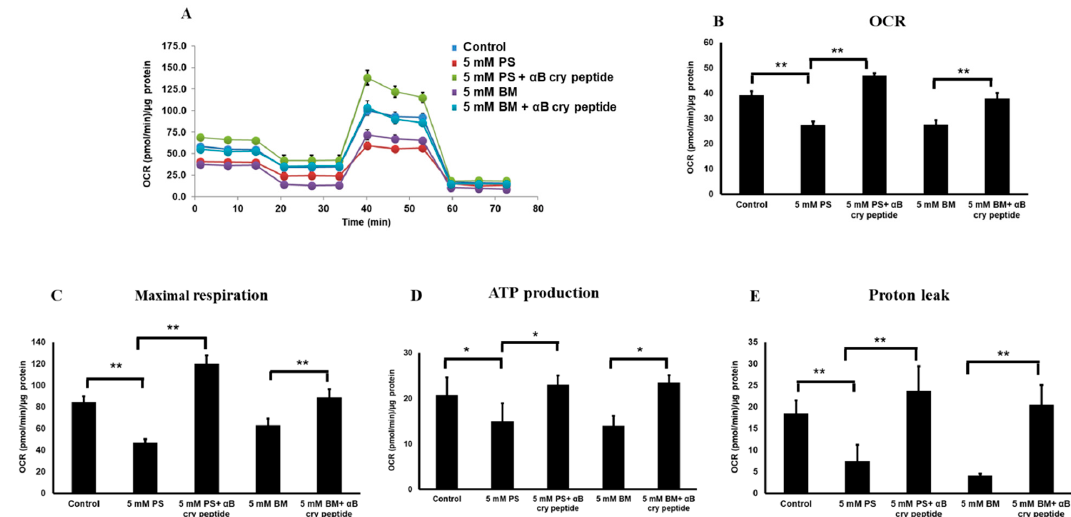
Figure 5. Inhibition of mGSH transporters OGC and DIC by PS and BM regulate mitochondrial bioenergetics in RPE cells. ( A ) Real-time analyses of respiratory parameters in RPE cells under OGC and DIC inhibition with or without α B cry peptide treatment. ( B – E ) Analysis of basal respiration, spare respiratory capacity, proton leak and ATP production, maximal respiration, and ATP production following OGC and DIC blockade in the presence or absence of α B cry peptide. A significant decrease in basal respiration was observed in DIC, and OGC inhibited cells along with a simultaneous decrease in ATP production. α B cry peptide co-treatment significantly increased mitochondrial respiration and ATP production. Data are mean ± SEM. n = 10; ** p < 0.01.